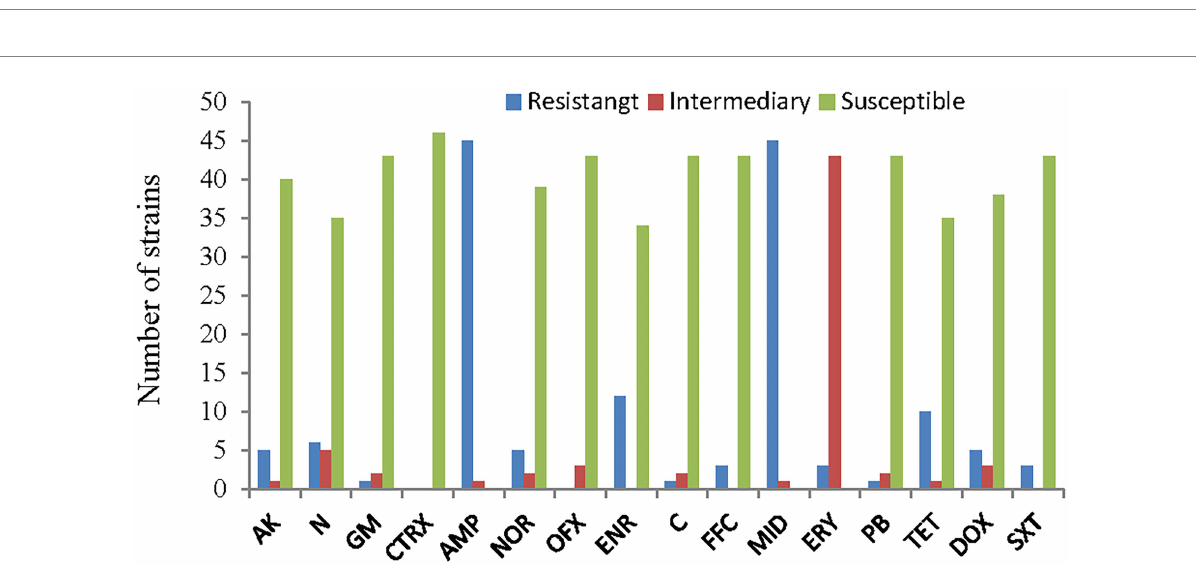
FIGURE 8 Antimicrobial susceptibility of the A. veronii isolates used in this study. AK, amikacin; N, neomycin; GM, gentamycin; CTRX; ceftriaxone; AMP, ampicillin; NOR, norfloxacin; OFX, ofloxacin; ENR, enrofloxacin; C, chloramphenicol; FFC, florfenicol; MID, midecamycin; ERY, erythromycin; PB, polymyxin-B; TET, tetracycline; DOX, doxycycline; SXT,